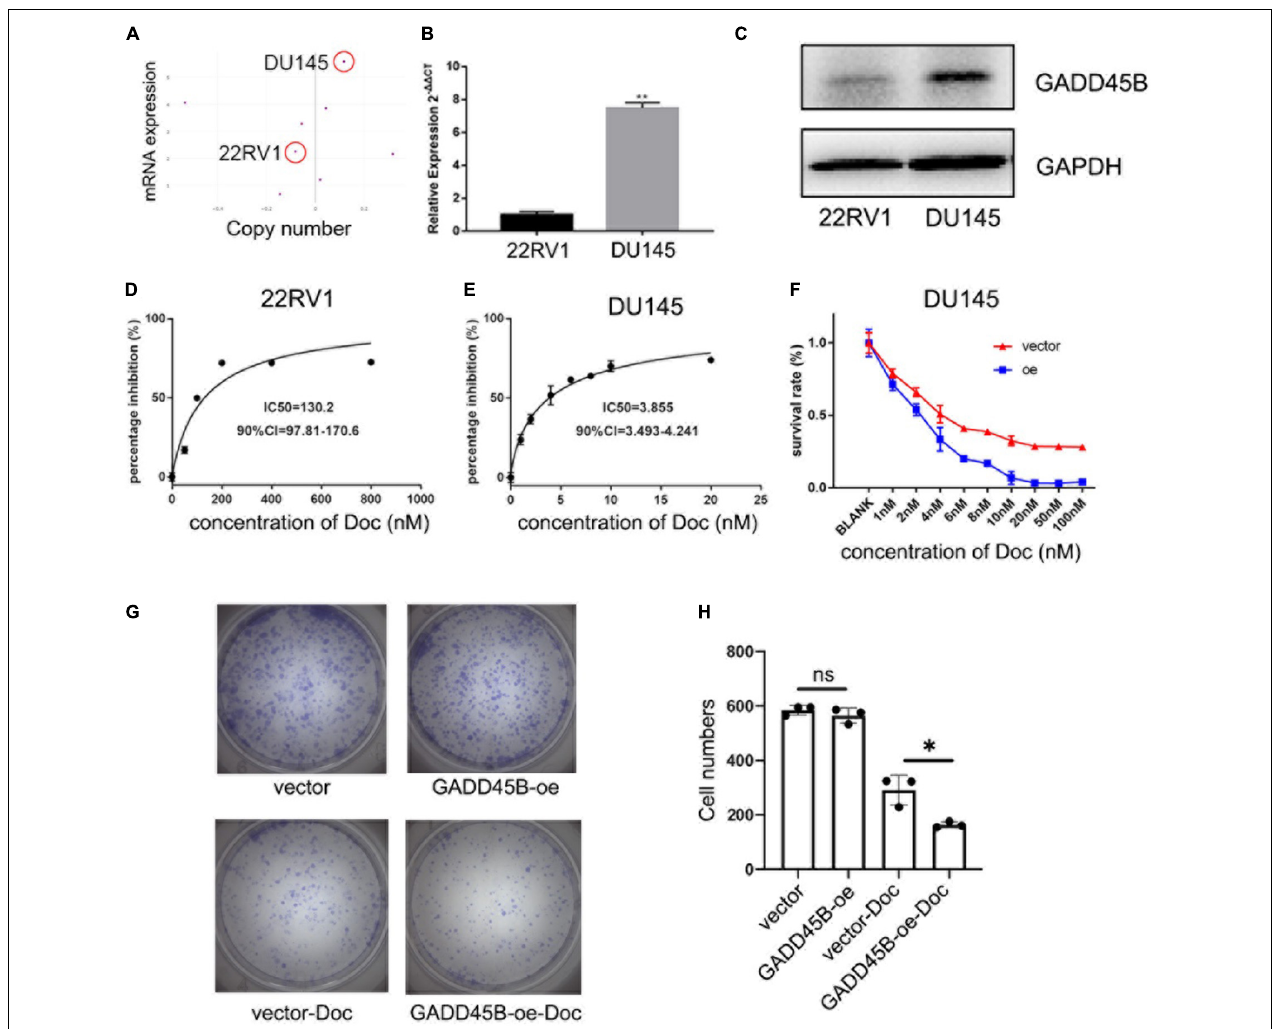
FIGURE 5 | GADD45B facilitated chemotherapy sensitivity of PCa cells. (A) mRNA expression and gene copy number of GADD45B in prostate-related cell lines from CCLE. (B,C) RT-PCR and WB analysis of GADD45B levels in DU145 and 22RV1 cell lines. (D,E) The MTS assay on the IC50 to docetaxel in DU145 and 22RV1 cells. (F) The MTS assay on the cell survival upon docetaxel treatment in GADD45B overexpressed cells. (G,H) Representative images and histogram analysis of colony formation assay before and after docetaxel treatment. * p < 0.05, ** p < 0.01, and not statistically significant p >